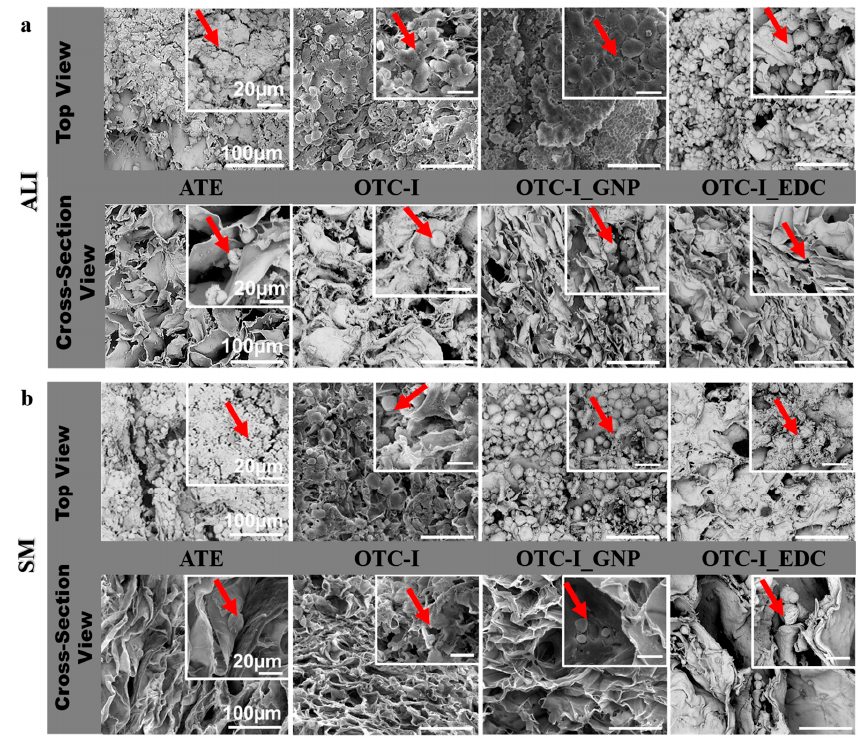
Figure 5. Morphological features of skin cells under ( a ) air-liquid interface (ALI) and ( b ) submerge (SM) condition via scanning electron microscopy. Top view referring the keratinocytes colonization